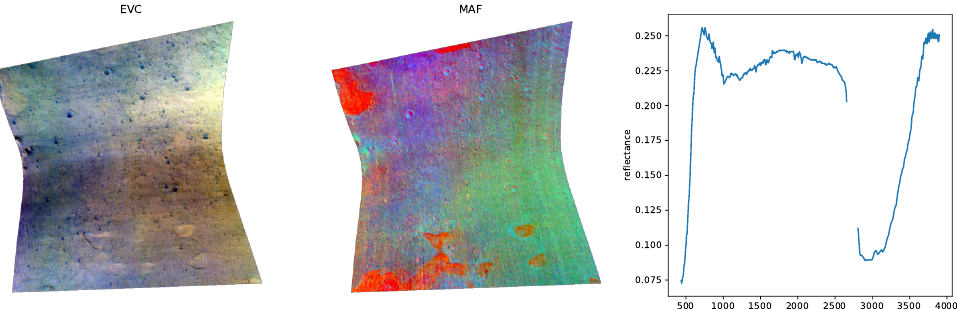
Figure 4. CRISM reflectance spectrum ( right ) next to a mafic ( center ) and enhanced visible color ( left ) CRISM FRT000066A4 browse